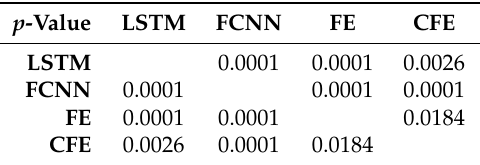
Figure 9. Evolution of the validation error (NLLLoss) during training of the four models on E1. Table 5. p -Values of the first experiment (E1), indicating the probability of the null hypothesis, i.e., the probability that the results of the models are not distinguishable.